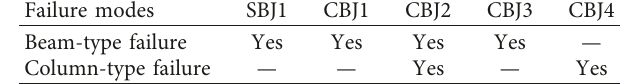
Table 3: All the specimens’ failure modes. Failure